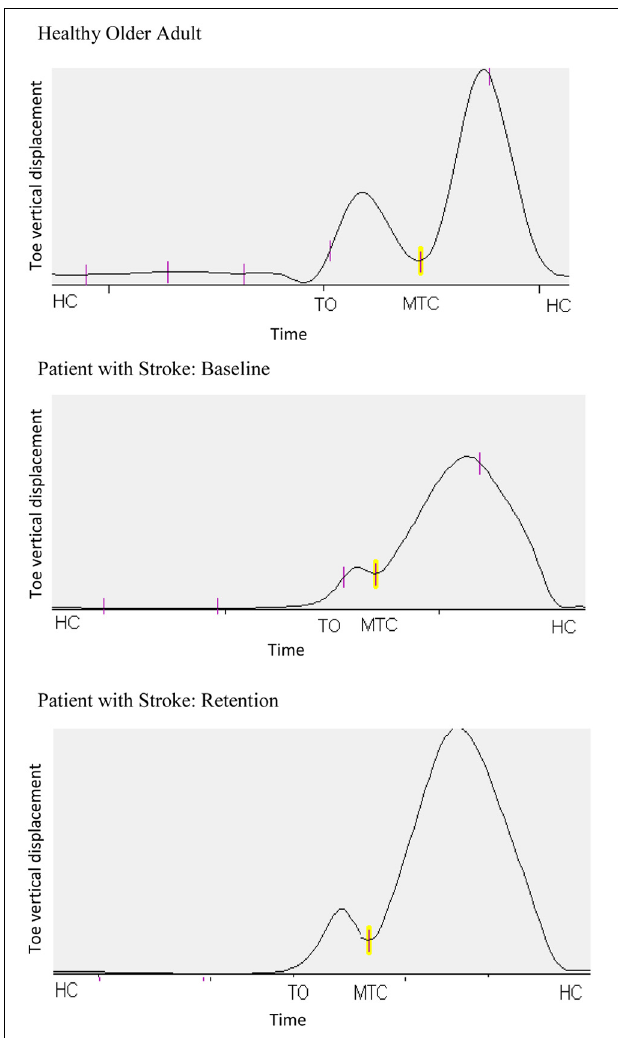
FIGURE 3 | Typical toe vertical displacement for one Healthy Older Adult and the Stroke Participant in pre-training Baseline and in Retention following training. The plots are one complete time-normalized stride cycle, defined by consecutive heel contact (HC) events. The swing-phase is from the first HC to Toe-Off (TO) and MTC is the Minimum Toe Clearance event at approximately